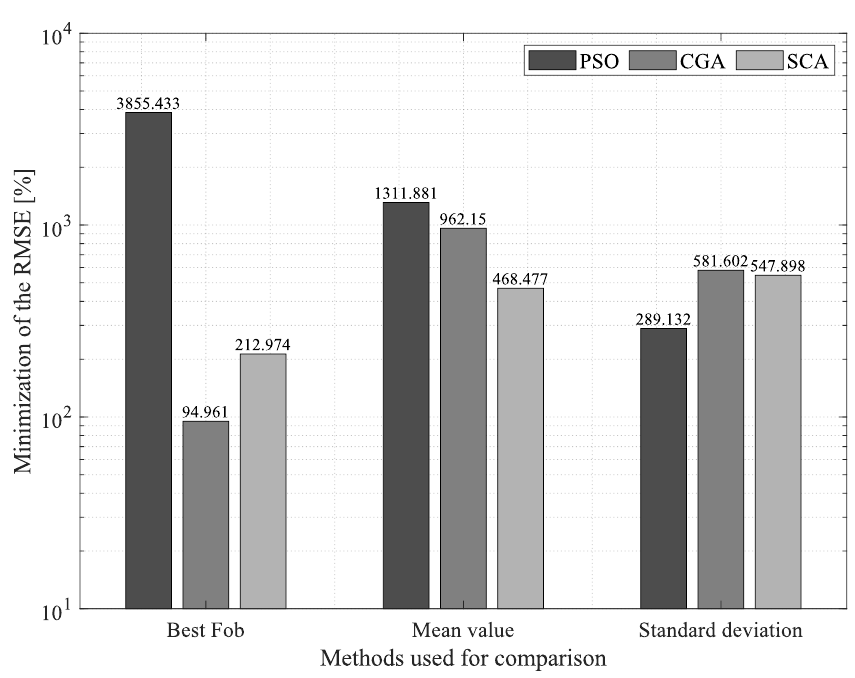
Figure 2. Minimization of the RMSE in the TDM of a KC 200 GT PV panel under a 500 W/m 2 irradiance level obtained by the SSA compared to other methodologies.